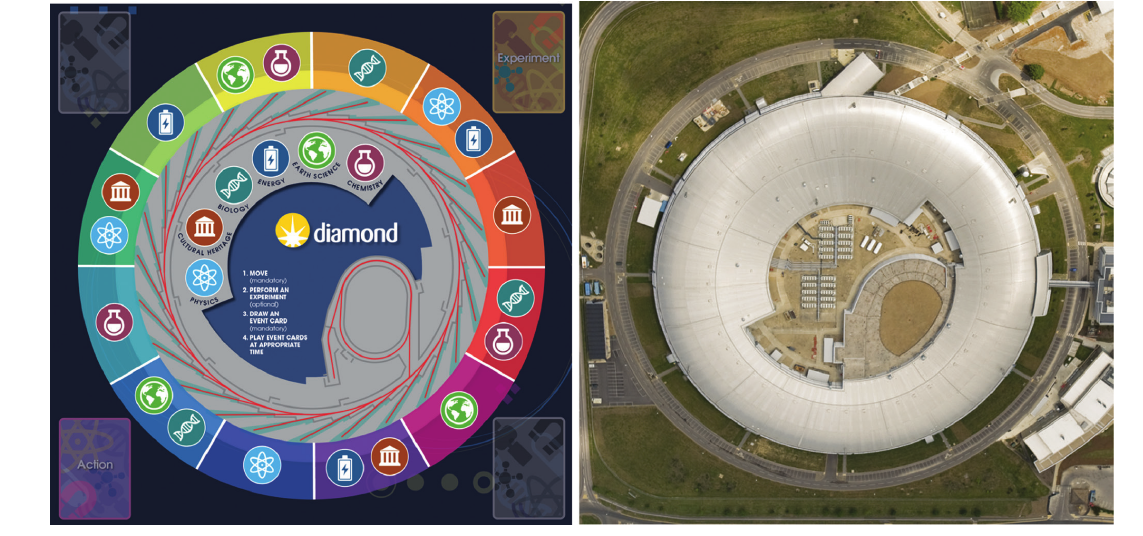
Figure 1. Diamond: The Game board (left), and an aerial image of the facility (right) (Source: Authors, 2022; left: Diamond Light Source,